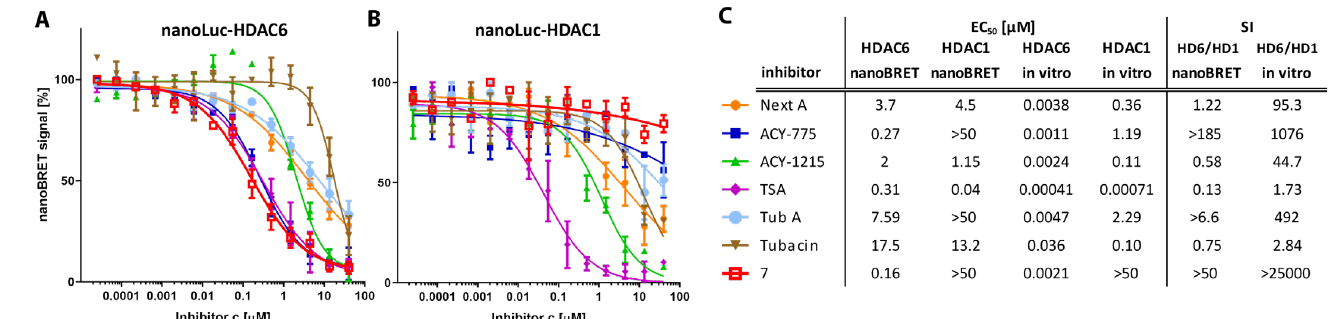
Figure 2. HDAC1 and HDAC6 cellular engagement assays. HEK293T/17 cells stably expressing HDAC-Luciferase fusion protein (HDAC-nanoLuc) were used for the nanoBRET target engagement assay [61,62], where tested inhibitors outcompete a fluorescent tracer in the HDAC active site resulting in a reduction in the BRET signal. Panels ( A , B ) Binding curves of tested inhibitors against HDAC6 ( A ) and HDAC1 ( B ). Panel ( C ) Calculated EC 50 values, selectivity indices, and correlation with in vitro data. Interestingly, with the exception of ACY-775 and 7, HDAC6is exhibits similar affinity toward HDAC1 and HDAC6 (HD1 and HD6) using the nanoBRET assay, while selectivity indices (SI) are much more pronounced using the in vitro data.